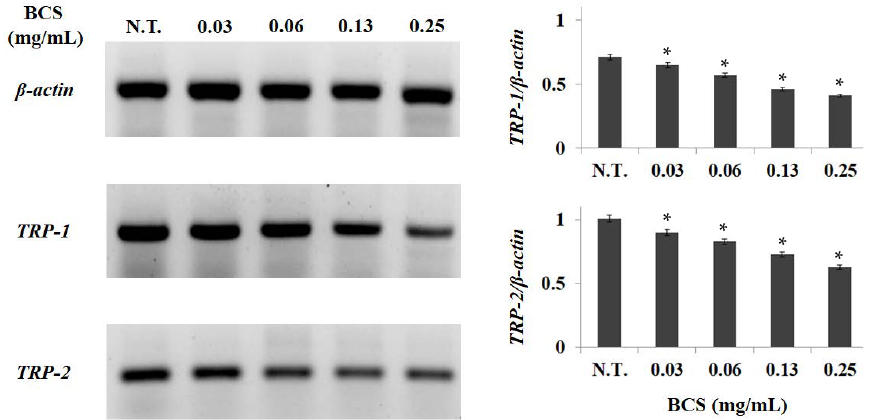
Figure 4. Effect of BCS on mRNA expressions levels of TRP-1 and TRP-2 in HDF cells. BCS: bioconverted chestnut inner shell extracts. The statistical analysis of the data was carried out by use of a t -test. Values are statistically significant compared to β -actin at * p < 0.05. β -actin was used as internal